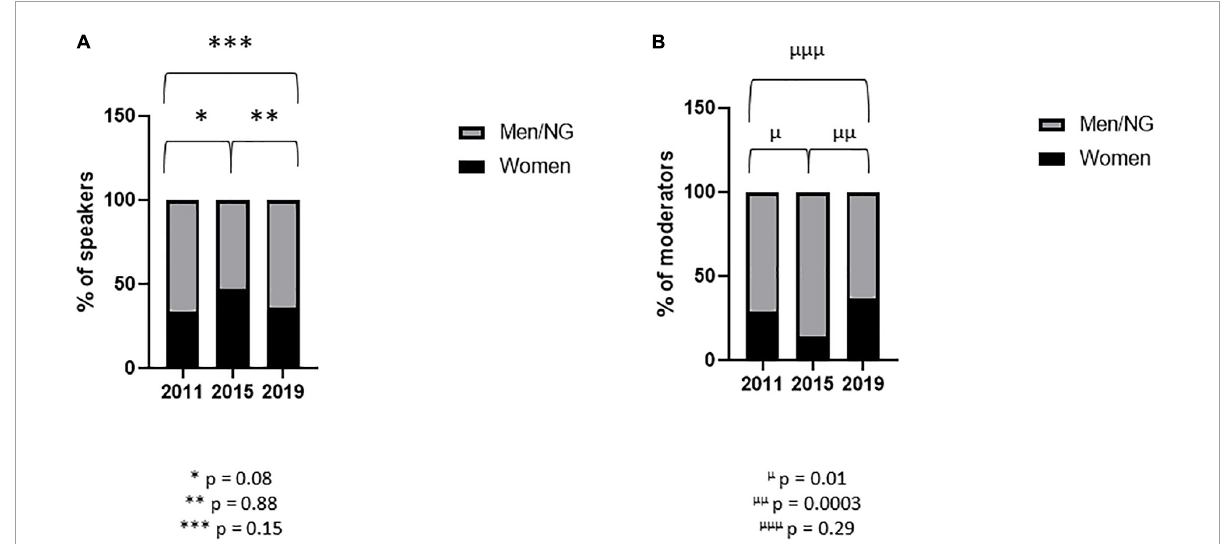
FIGURE7 Women speakers and moderators in educational sessions. Proportion of women speakers (A) and moderators (B) in educational sessions during the three congresses. Variables are presented as percentages. After contingency analysis, variables were compared by Fisher’s exact